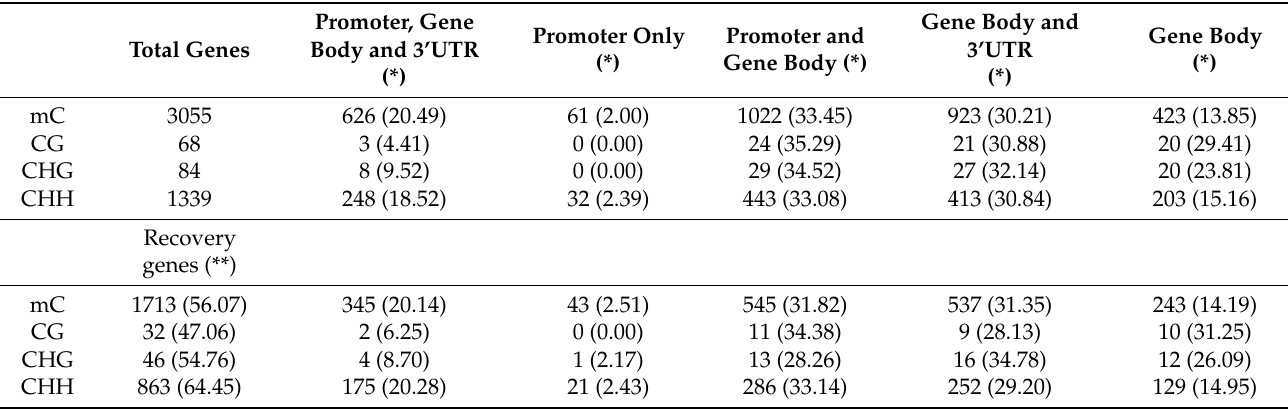
Table 3. Botrytis cinerea in vitro induced differentially methylated regions overlapping with genes. DRMs overlapping with genes (i.e., regions presenting significantly different methylation levels between one sample and the other two samples (FDR < 0.01)) were determined using a three-sample Kruskal-Wallis test. Methylation levels were analysed by sliding window analysis using swDMR. DMRs were determined for all cytosines and for three methylation contexts. DMRs were grouped according to the genic region they overlapped with (i.e., promoter, promoter and gene body, promoter, gene body and 3’UTR, gene body and 3 (cid:48) UTR and gene body). (**) Percentage of the total DMRs overlapping with each particular genic region. (*) Percentage of the total number of genes showing a methylation recovery